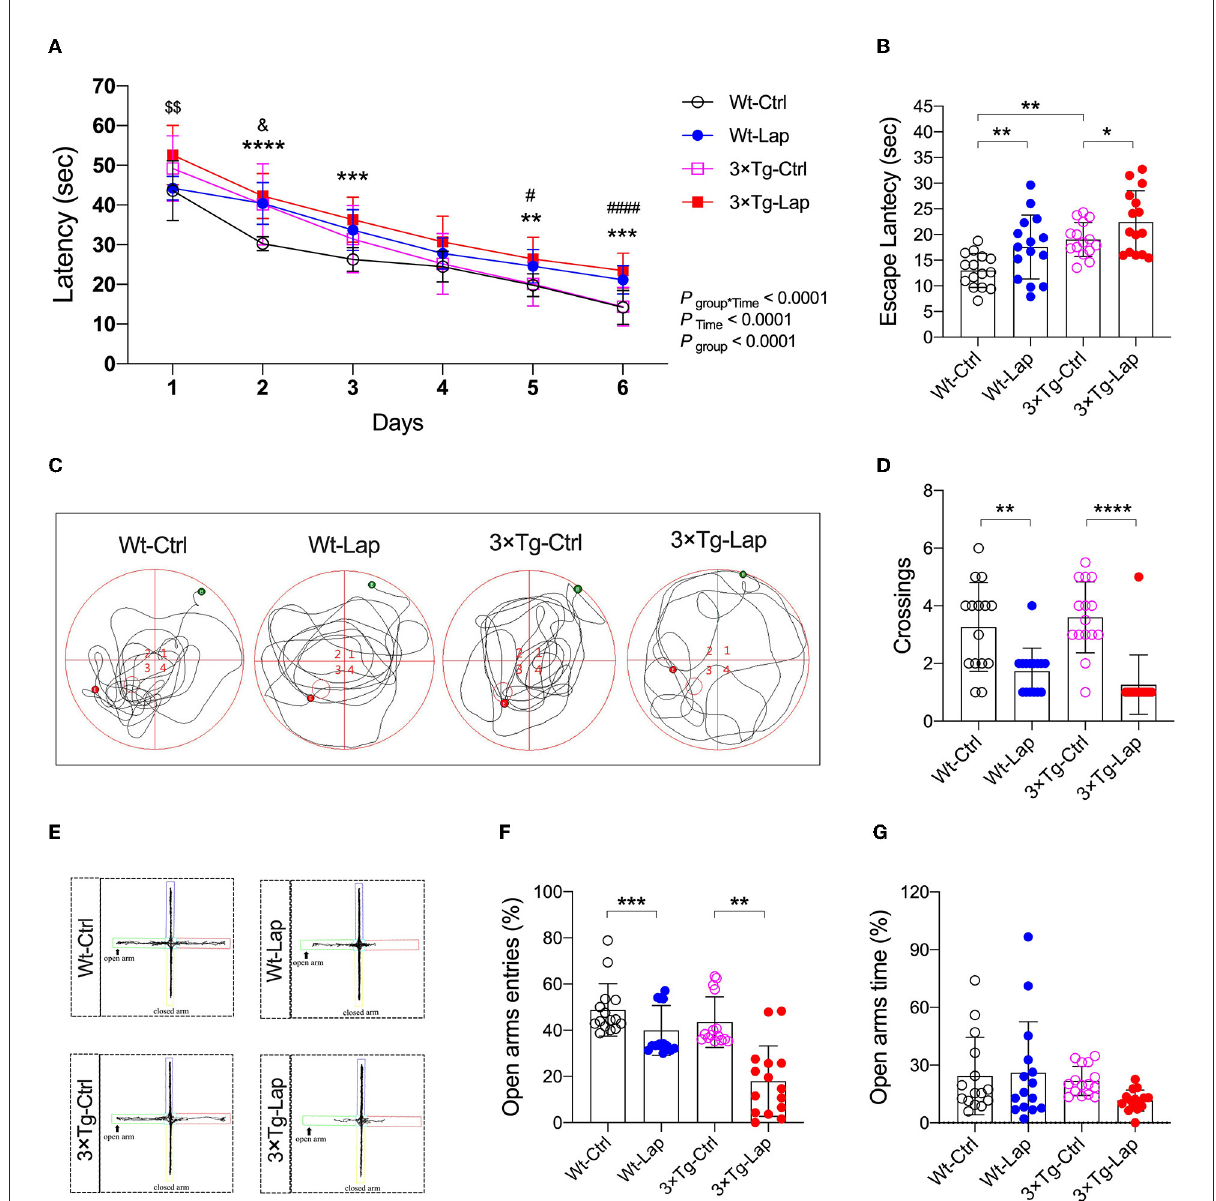
FIGURE4 Laparotomy induced cognitive impairment in both wild-type and 3 × Tg AD mice. (A) In the wild-type and AD mice without or with laparotomy, the learning ability of spatial acquisition was made during the training session in the MWM test. F (15,280) = 4.066. ** P < 0.01, *** P < 0.001, **** P < 0.0001, Wt-Lap vs. Wt-Ctrl; # P < 0.05, #### P < 0.0001, 3 × Tg-Lap vs. 3 × Tg-Ctrl; & P < 0.05, 3 × Tg-Ctrl vs. Wt-Ctrl; $$ P < 0.01, 3 × Tg-Lap vs. Wt-Lap. (B–D) On postoperative day 12 after laparotomy, escape latency [F (3,56) = 9.531, P < 0.0001], representative swimming route, and number of crossings [F (3,56) = 14.03, P < 0.0001] were recorded in the probe test of the MWM test. (E–G) In the EPM test, representative moving tracks, the number of entries [F (3,56) = 18.44, P < 0.0001] and time spent [F (3,56) = 2.098, P = 0.1108] in the open arm were summarized. Wt, wild-type mice; 3 × Tg, triple transgenic mice; Ctrl, control; Lap, laparotomy. Data are present as mean ± SEM and were analyzed using one-way ANOVA using Tukey’s post hoc test, n = 15, * P < 0.05, ** P < 0.01, *** P < 0.001, **** P <